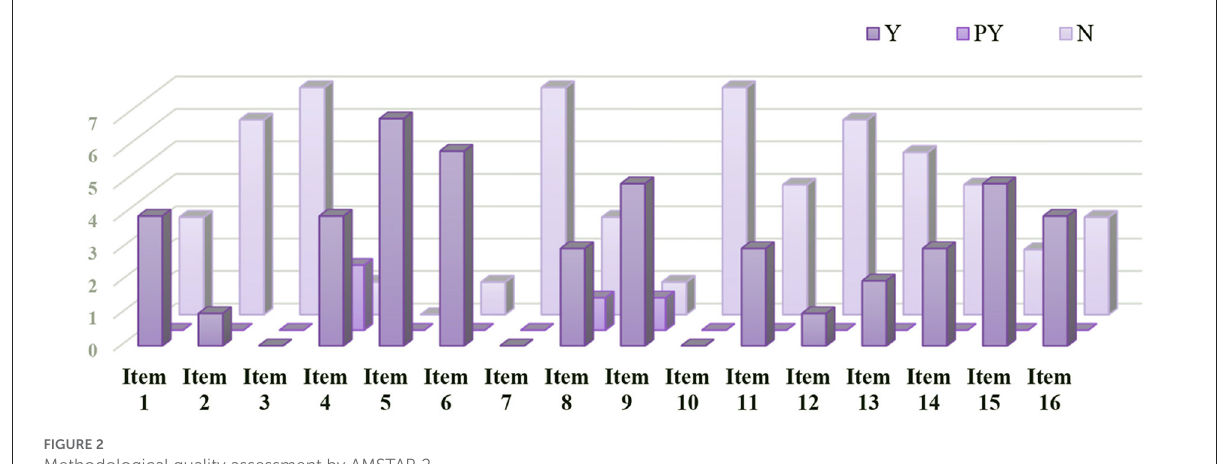
FIGURE2 Methodological quality assessment by AMSTAR 2.